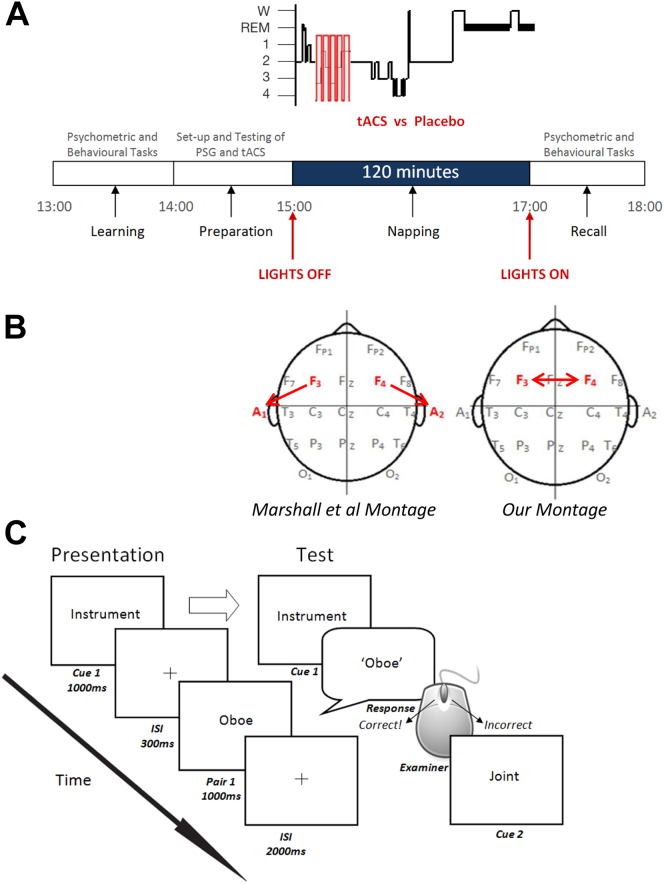
Experimental set up. A, Experimental design. B, Electrode montage. C, PAL task protocol: Following initial presentation and testing (as shown in the diagram) if subjects scored > 30% correct, they progressed to the preparation stage (see Fig. 1A). If however, they scored <30% correct then they were presented the word list again at twice the presentation speed. Following representation they were again tested without feedback, as before. No subjects failed to score 30% following the second presentation.